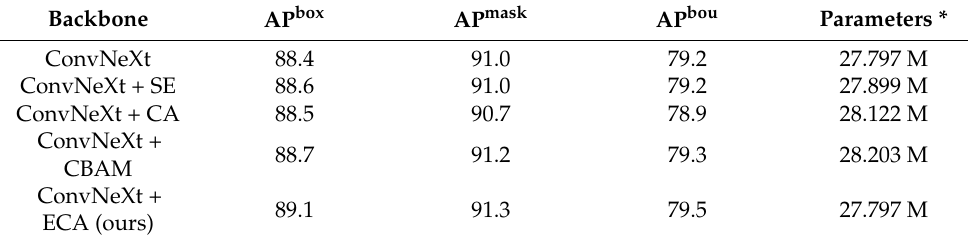
Table 4. Comparison with different attention modules in